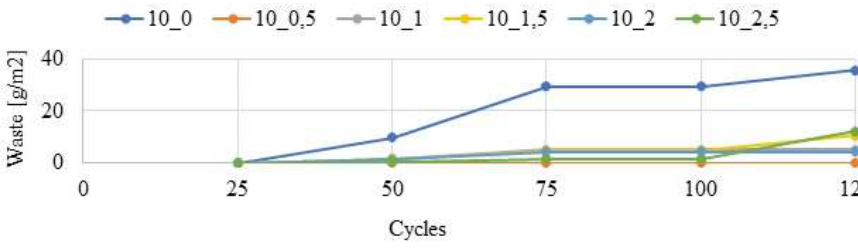
Figure 8. Series no. 10 - Results of the chemical thaw substances resistance tests.